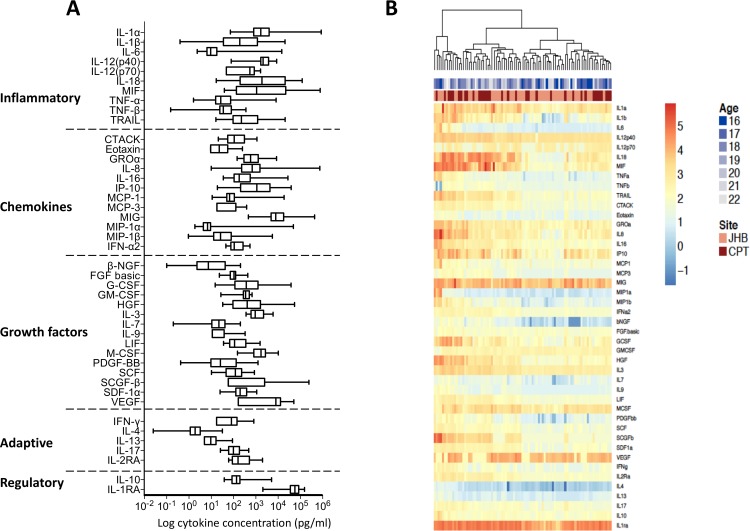
Concentrations of cytokines in genital secretions from reproductively healthy AGYW from South Africa.A. Box-and-whisker plots showing the median cytokine concentration and 95% confidence intervals for all cytokines measured, grouped by functional classes (inflammatory cytokines, chemokines, growth factors, adaptive and regulatory cytokines respectively). B. Unsupervised hierarchical clustering of all measured genital cytokines in healthy women. The site is represented by light (Cape Town) and dark red (Johannesburg), while ages are represented by the shades of blue.